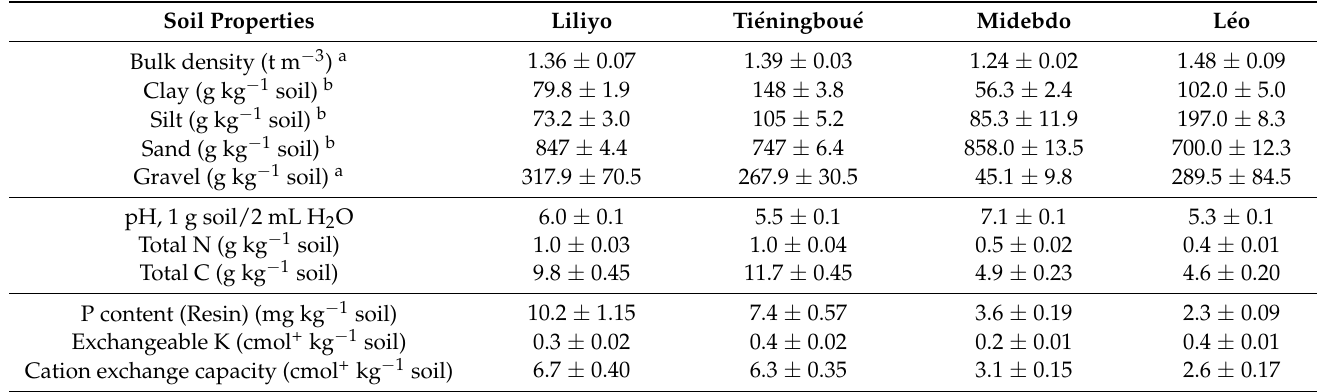
Table 2. Soil properties in the 0–30-cm layer of the field trials at the installation in 2016 in Liliyo and Ti é ningbou é (C ô te d’Ivoire), and Midebdo and L é o (Burkina Faso). Data are mean values ± standard